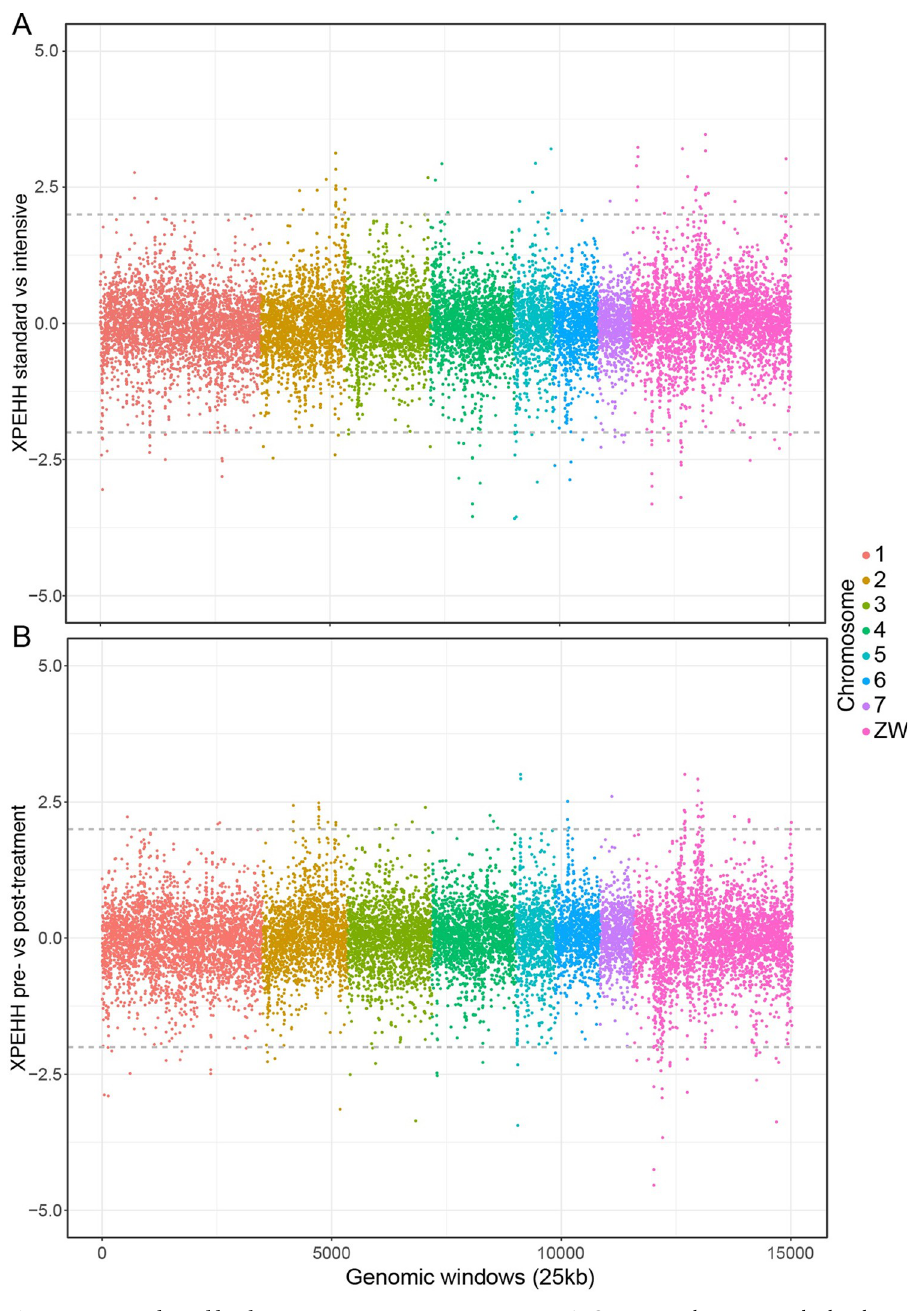
Fig 6. XP-EHH coloured by chromosome among treatment groups. A. Comparison between standard and intensive treatment groups. B. Comparison between pre-treatment and post-treatment groups. Positive values in panel A represent windows under stronger selective pressure in annual vs quarterly treatment arms. In panel B, positive values represent windows under stronger selection in pre-treatment than post-treatment samples. (Fig 7C), there were similar numbers of high- and low-clearance villages in the two arms. These differences were largely driven by a small number of individuals in some villages with very low (even negative—implying a higher egg count after treatment than before) ERR values (Fig 7A). Unlike in a previous study [9], no ERRs were significantly below the 90% threshold,